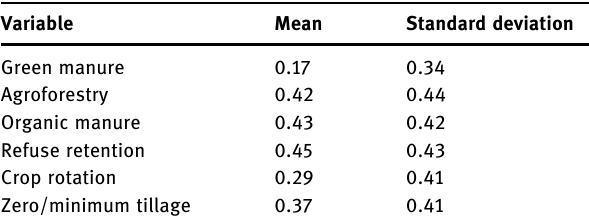
Table 3: Adoption of AP - CSAPs on the farmers ’ plots Variable